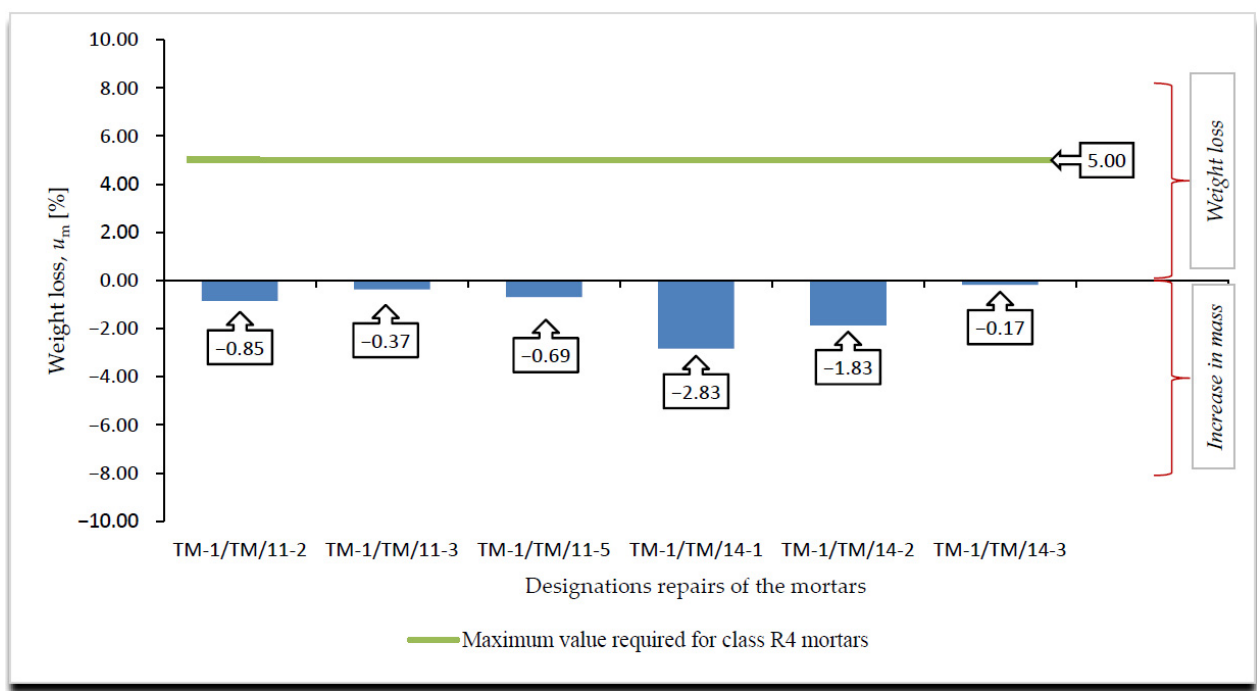
Figure 8. Summary of averages values of weight loss of R4 class mortars after frost resistance testing, according to [19], u m [%].